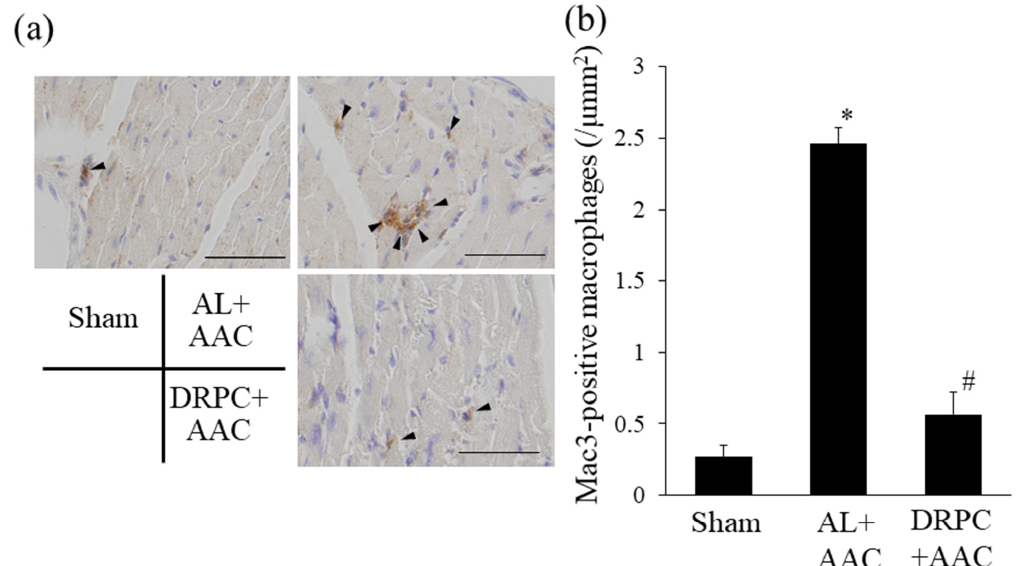
Figure 7. Effects of dietary restriction preconditioning on pressure overload-induced cardiac inflammation. ( a ) Represen- tative photomicrographs of MAC3-positive macrophage infiltration in cardiac tissue 2 weeks after surgery. Arrowheads indicate MAC3-positive macrophages. Bars indicate 50 µ m. ( b ) Number of infiltrated macrophages in the left ventricle. ( n = 3). * p < 0.05 versus Sham. # p < 0.05 versus AL+ AAC.